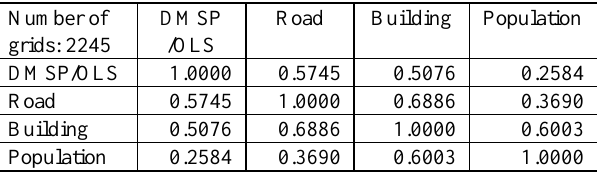
Table 4. Correlation table in urban area of Tohoku region